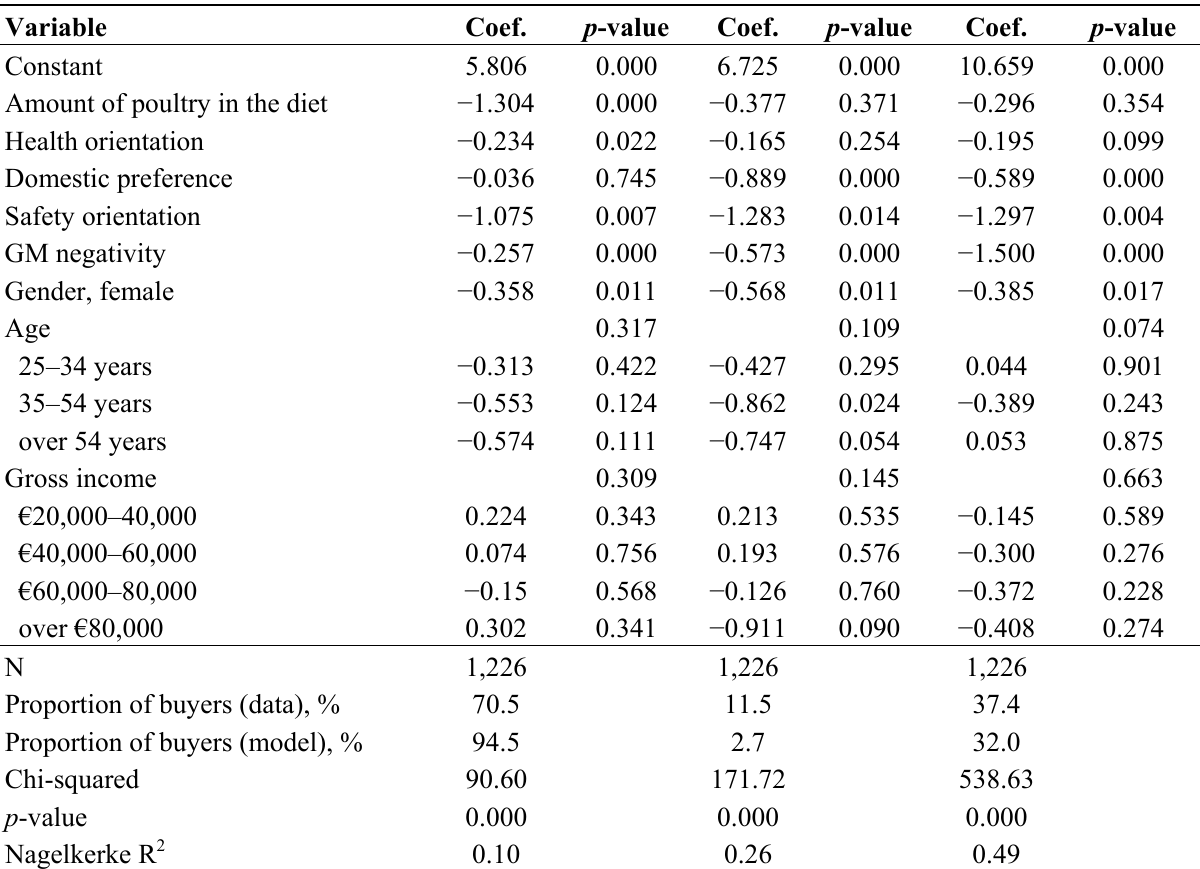
Table 5. Logistic regressions for the intention to purchase risk products (dependent variable: buy = 1, not buy =